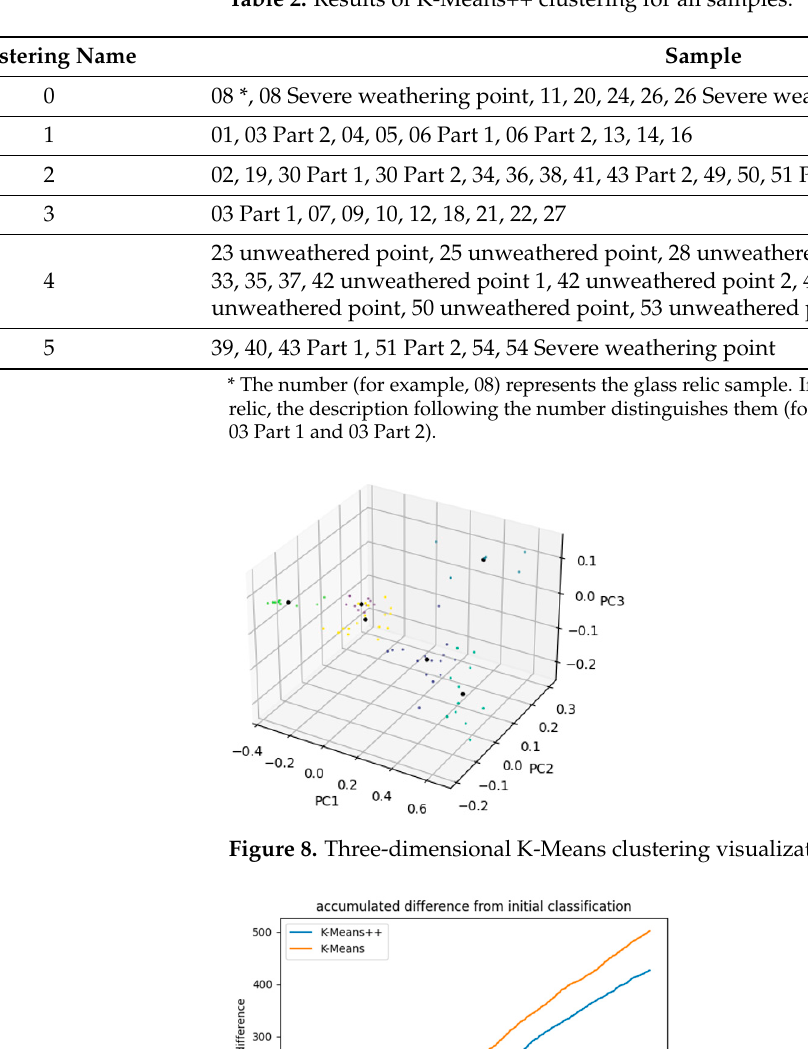
Figure 7. Three-dimensional K-Means++ clustering visualization. Table 2. Results of K-Means++ clustering for all samples.